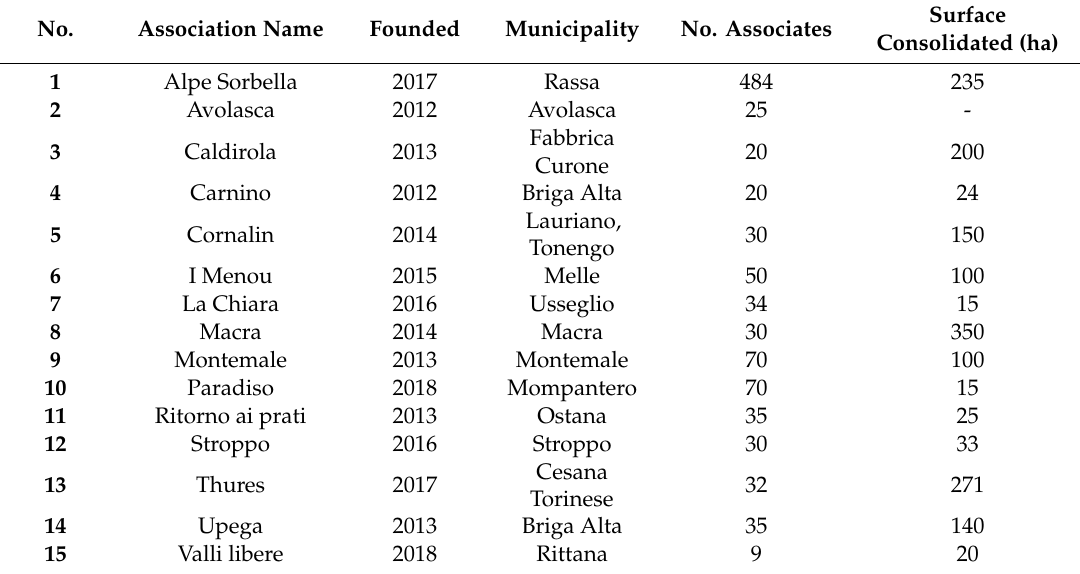
Table 1. Operating land consolidation